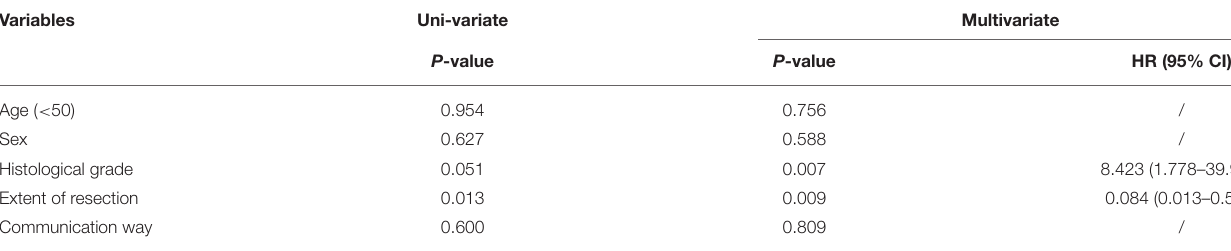
TABLE 5 | Factors associated with DFS in 43 patients with skull base meningiomas with extracranial